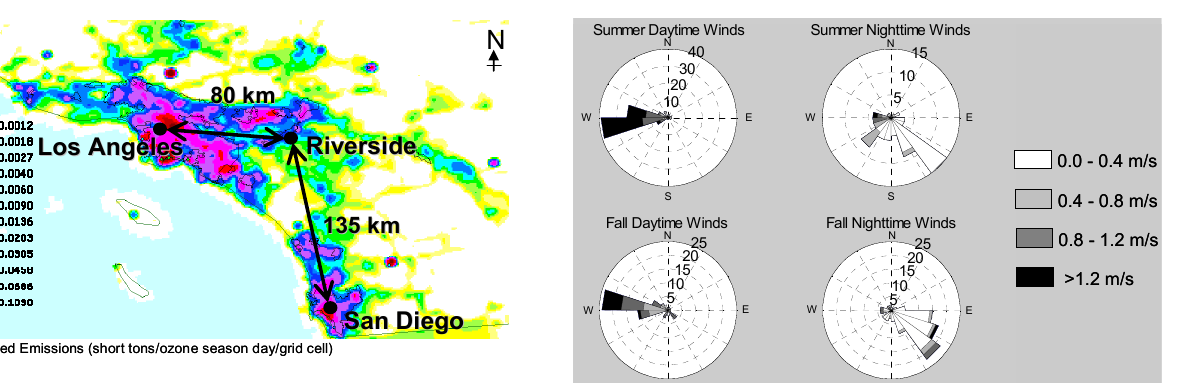
Fig. 1. View of the ground-based field site at Riverside, CA (33 ◦ 58 0 18 00 N, 117 ◦ 19 0 17 00 W). Shown are anthropogenic PM 2 . 5 - PRI emissions in short tons/ozone season day/grid cell, plotted on a 4-km Lambert-Conformal grid. This emission map was created using the NOAA-NESDIS/OAR Emission Inventory Mapviewer found at: ( http://map.ngdc.noaa.gov/website/al/emissions/viewer. htm), maintained by Gregory Frost, NOAA.